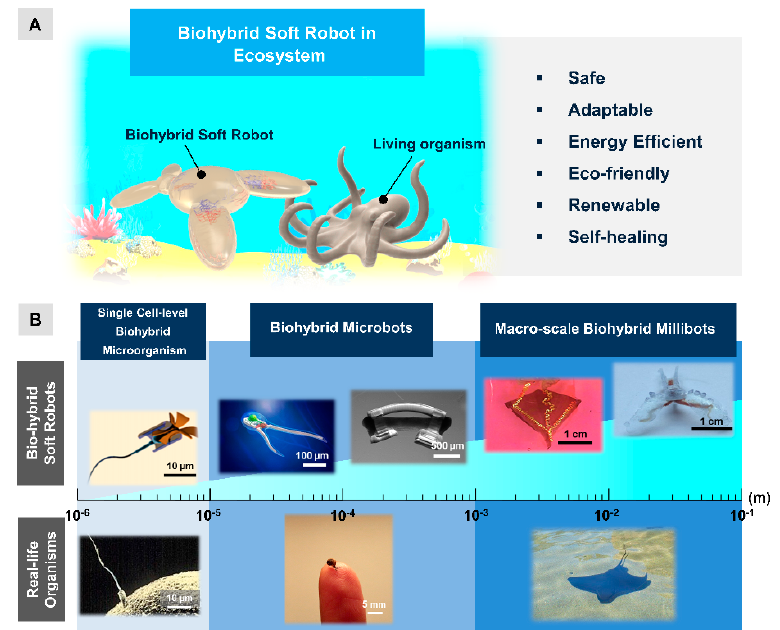
Figure 1. ( A ) Illustration of a biohybrid soft robot safely interacting with a living organism in an ecosystem (left) and a list of advantages of biohybrid soft robotics (right). ( B ) Increasing sizes for biohybrid soft robots from sub-micron scale to centimeter scale (top) and corresponding inspired real-life organisms (bottom). Biohybrid Soft Robotics: sperm-bot, [14] © Copyright 2017, ACS.